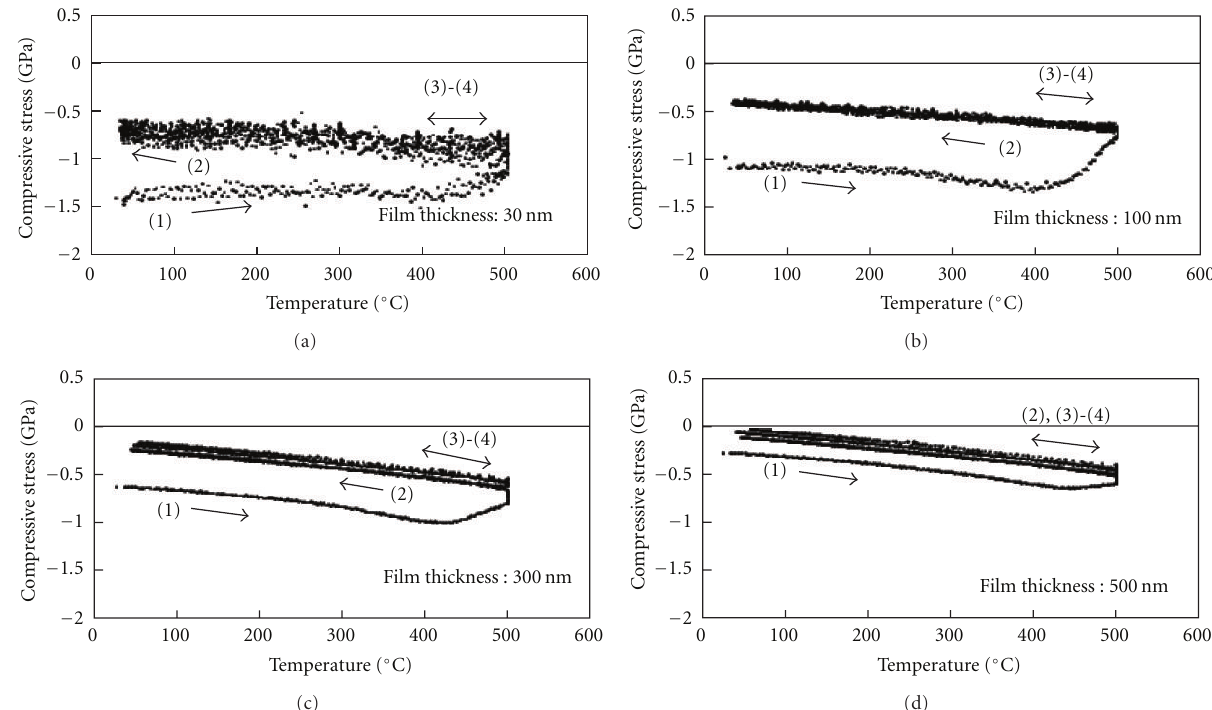
Figure 4: Residual stress behavior during heat-cycle testing (room temp: − 500 ◦ C) in an atmosphere of flowing Ar gas for GZO films formed by the RPD